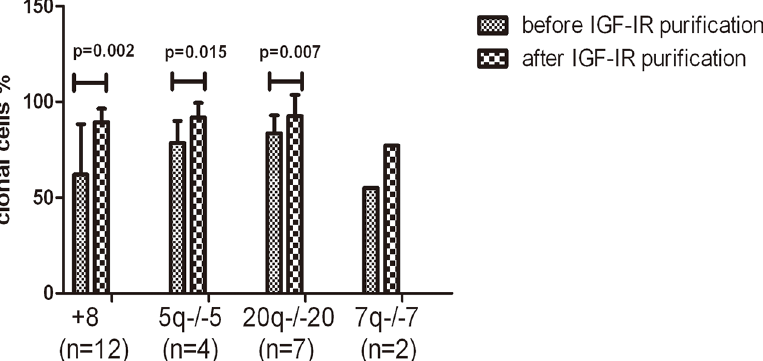
Fig 2. Changes in clonal cells from 25 MDS patients before and after IGF-IR purification, After positive IGF-IR sorting, the percentages of clonal cells in BMNCs from 25 MDS patients significantly increased. In the 4 groups classified based on chromosomal abnormalities (+8, 5q-/-5, 20q-/-20, and 7q-/-7), the percentages of clonal cells after sorting all increased compared to the percentages before sorting. The first 3 groups had statistical significance, and the last group could not be analyzed due to the limited number of cases. The increase in the +8 group was the most significant, and this increase reached 27%. doi:10.1371/journal.pone.0140372.g002 Changes in the percentage of clonal cells after PPP intervention PPP is a specific inhibitor of IGF-IR and blocks IGF-IR downstream signal transduction [12]. CD34 + cells from 6 MDS patients with chromosomal abnormalities were expanded in cell cul- ture. Cells were collected at 0, 24, 48, 72, 96, and 168 h (7 d) after treatment with 1 μ M of PPP and the percentage of clonal cells was determined using FISH. Additionally, cell mortality was calculated after trypan blue staining. The results showed that the percentage of clonal cells decreased progressively with the increase of incubation time in PPP containing medium. The average percentage decreased from the initial 80.7% to 60.0% ( P = 0.001) (Table 2 and Fig 3A). The blank control showed the proportional decrease of both clonal cells and the normal cells in the cultured cells, but did not show a decreasing trend of the percentage of clonal cells. The cell mortality increased over time and the difference from the control was statistically significant ( P = 0.005) (Fig 3B).